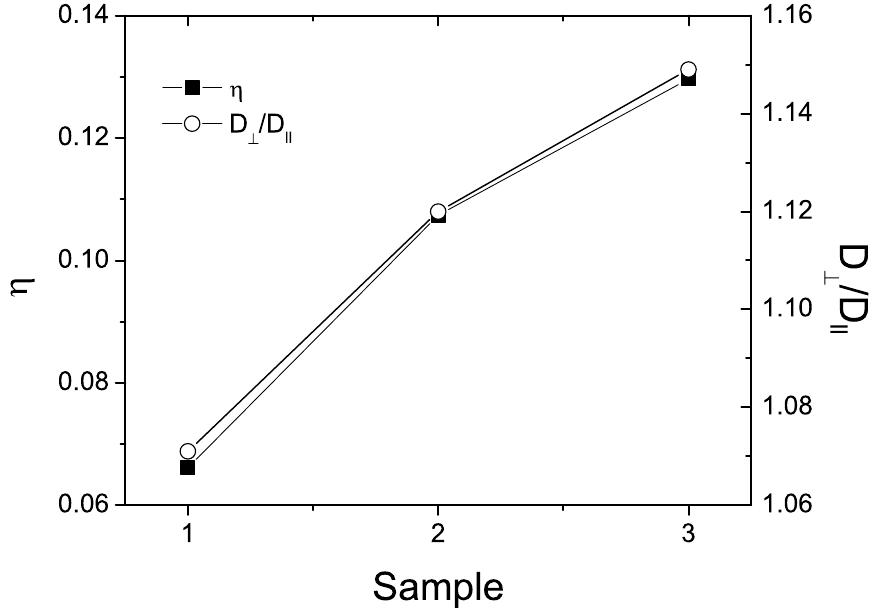
Figure 8. Anisotropy of water self-diffusion ( η ) and D ⊥ / D (cid:107) , for fully hydrated cSPEEK membranes. Sample code: Sample 1 = cSPEEK crosslinked at 150 °C for 60 min; Sample 2 = cSPEEK crosslinked at 200 °C for 30 min; and Sample 3 = cSPEEK crosslinked at 200 °C for 60